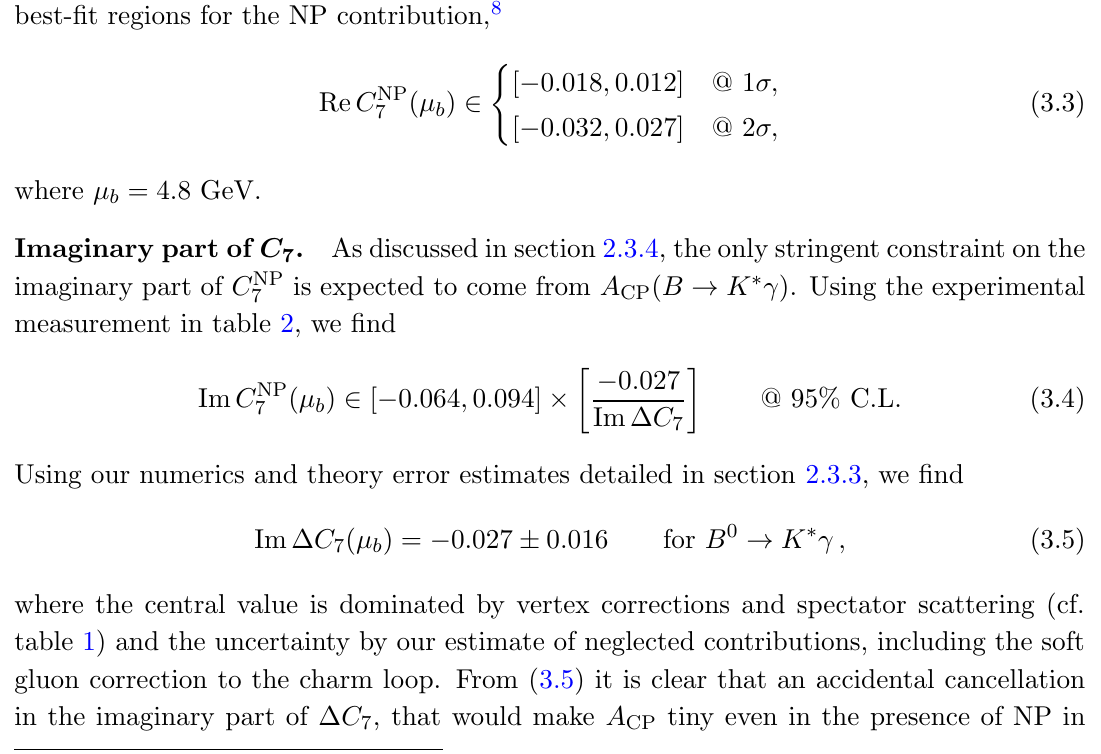
Figure 2 . Constraint on NP contributions to the real part of the Wilson coe(cid:14)cient C exclusive and inclusive branching ratios as well as combined constraint from these branching